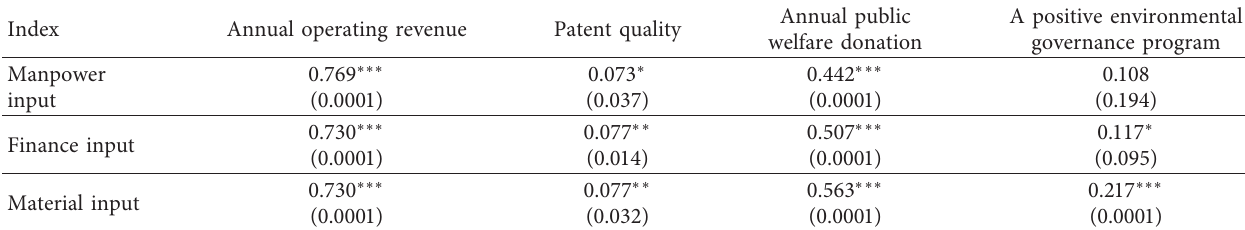
Table 2: Pearson test of green innovation input-output index of listed energy companies in China.